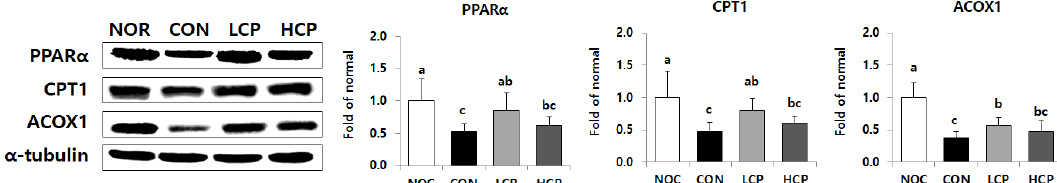
Figure 5. Effects of two skate skin-derived collagen peptides with different molecular weights on hepatic protein expression of beta-oxidation. Data are mean ± standard deviation (SD) ( n = 10 per group). Experimental groups were divided into four groups; m/m mice were orally administered water as a vehicle (NOR group) whereas db/db mice were orally administered water (control group, CON), LCP (LCP group), or HCP (HCP group) at a dose of 200 mg·kg bw −1 ·day −1 for 8 weeks. a-–c Different letters mean significant differences to one-way analysis of variance (ANOVA), followed by Duncan’s multiple-range test at p < 0.05.